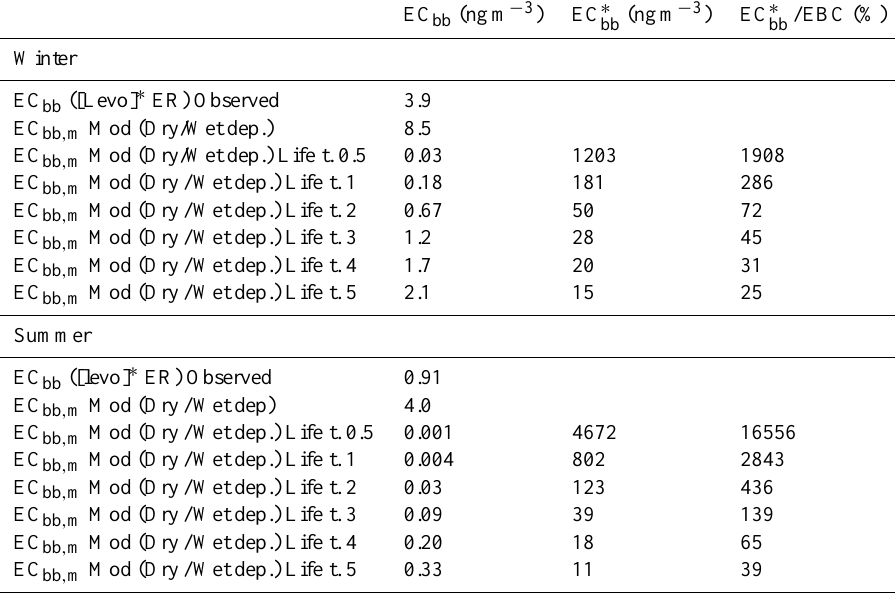
) mean concentrations of EC assuming bb to bb